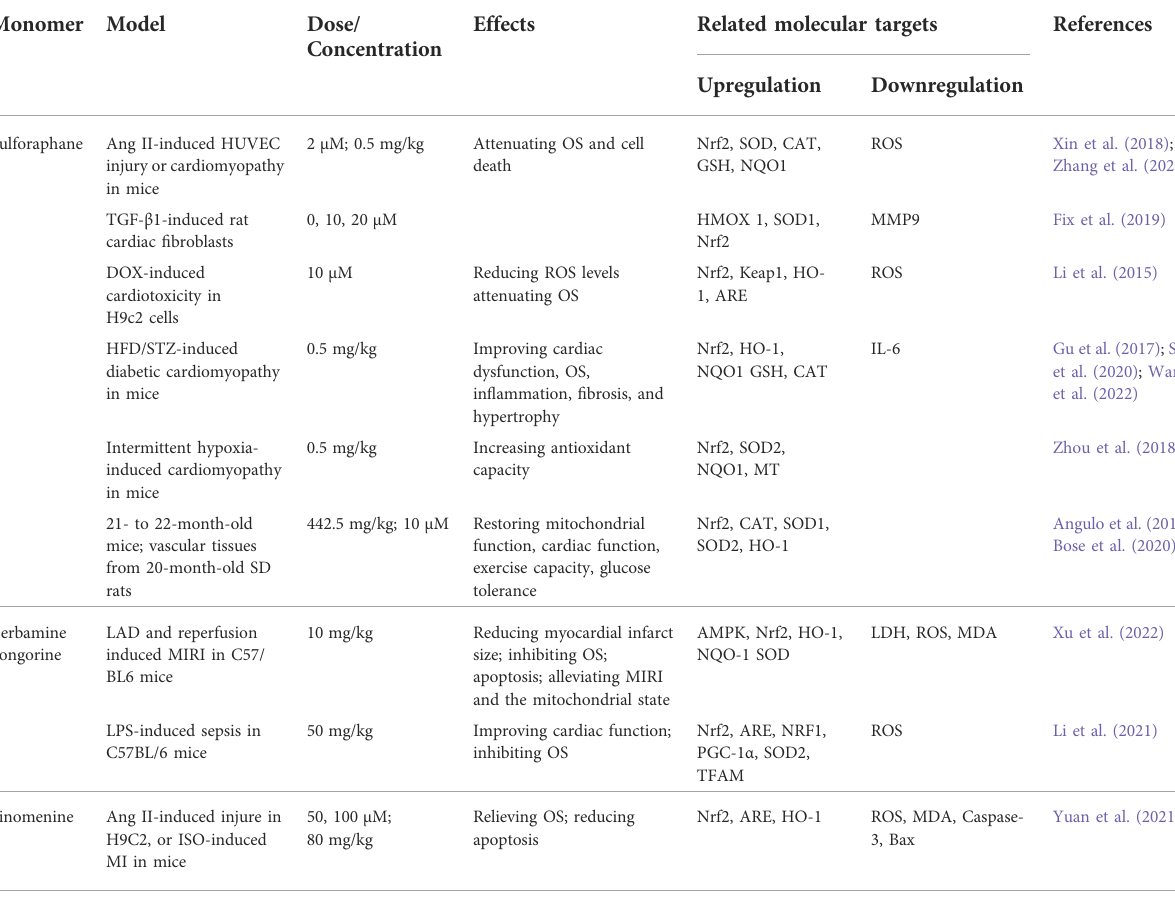
TABLE 4 Protective effects of alkaloids on vascular endothelial cells.